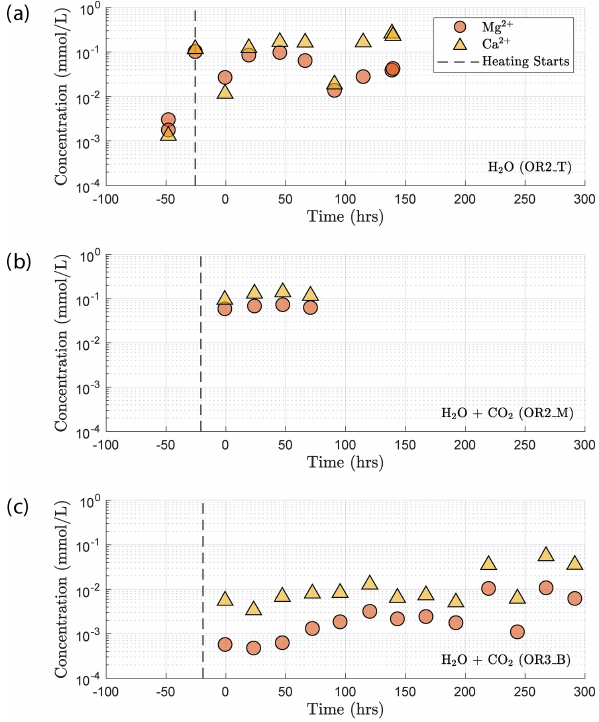
Figure 13. Concentration of Mg 2 + and Ca 2 + in the sampled fluid from (a) H 2 O, (b) H 2 O + CO 2 closed and (c) H 2 O + CO 2 open experiments. Time 0 marks the start of the first creep stepping.